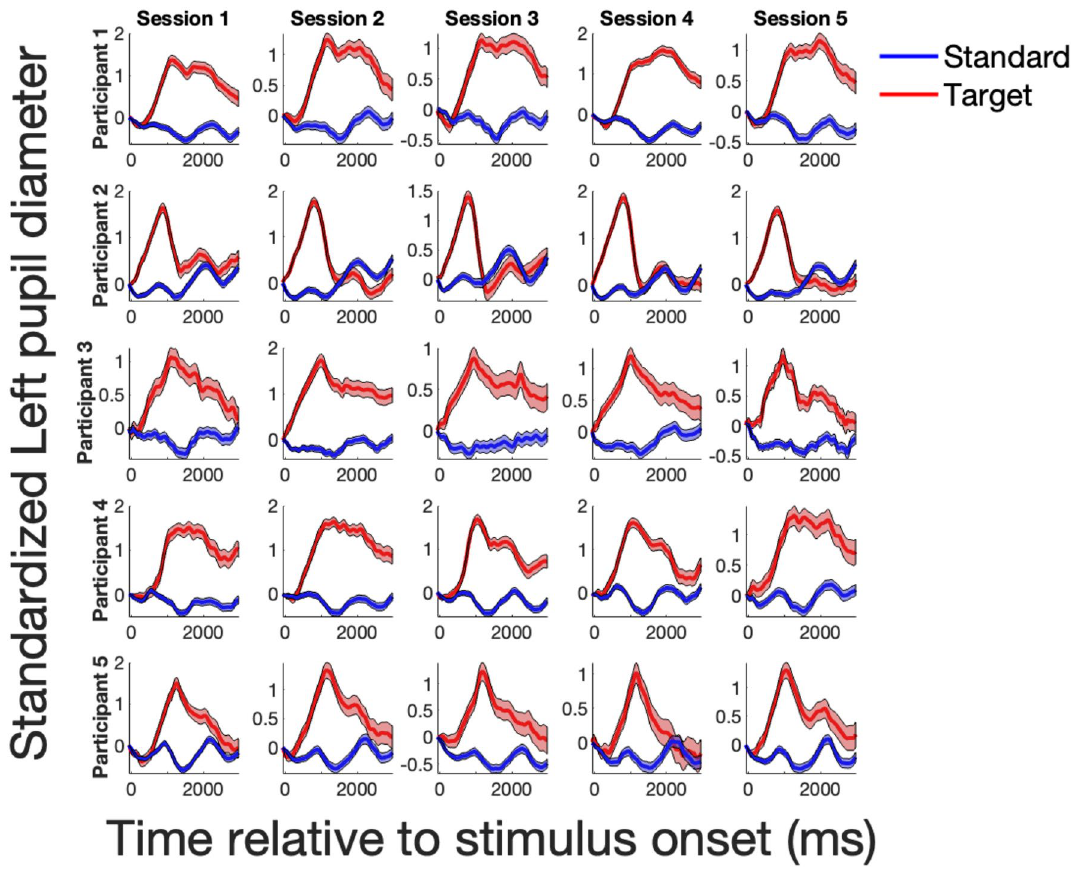
Figure 2. Illustration of pupil response curves over five experimental sessions for five participants. Each row depicts pupil responses for a single participant. Each column shows a different experimental session. Pupil responses to the target tone are shown in red, and pupil responses to the standard tone are also plotted for comparison and shown in blue. Response curves were different between participants, but highly reliable within